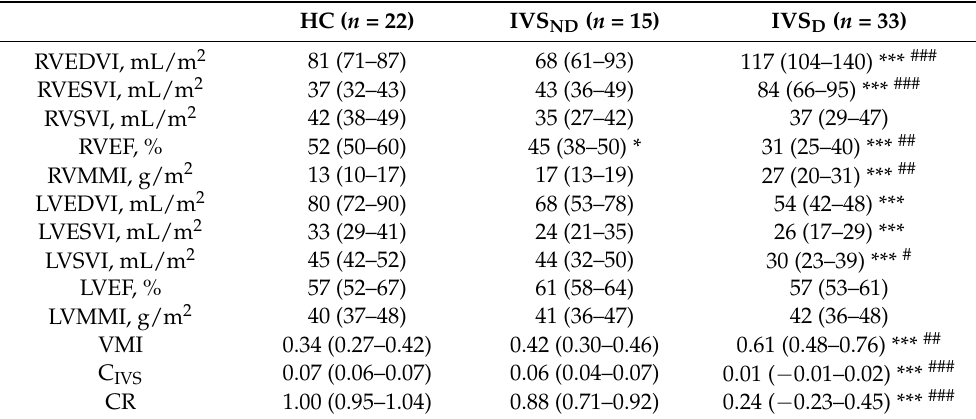
Table 2. CMR-derived morphologic and functional parameter characteristics in the health control and PH patients.